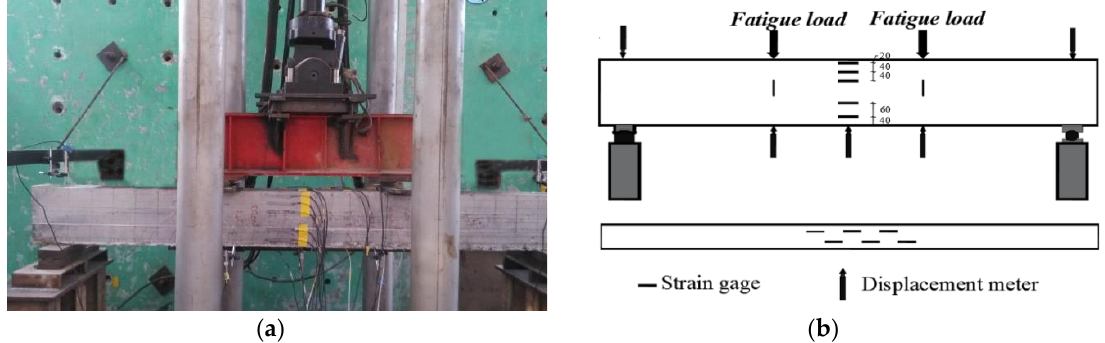
Figure 2. Fatigue testing devices of test beams: ( a ) live-action photo; ( b ) gauge installation.